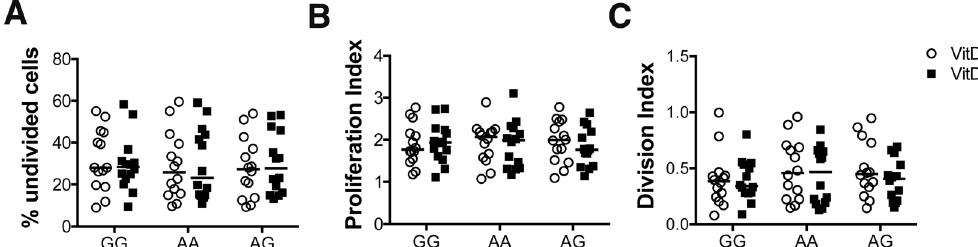
Figure 4. GG, AA and AG individuals show similar levels of proliferation. CD4 + CD25 − T cells were activated in vitro with aCD3 antibody and CHO-CD80 cell line in the presence or absence of 1,25(OH) 2 D 3 for 5 days. Data show ( A ) the percentage of undivided cells, ( B ) the proliferation index and ( C ) the division index across genotypes in the presence (VitD + ) and absence (VitD − ) of vitamin